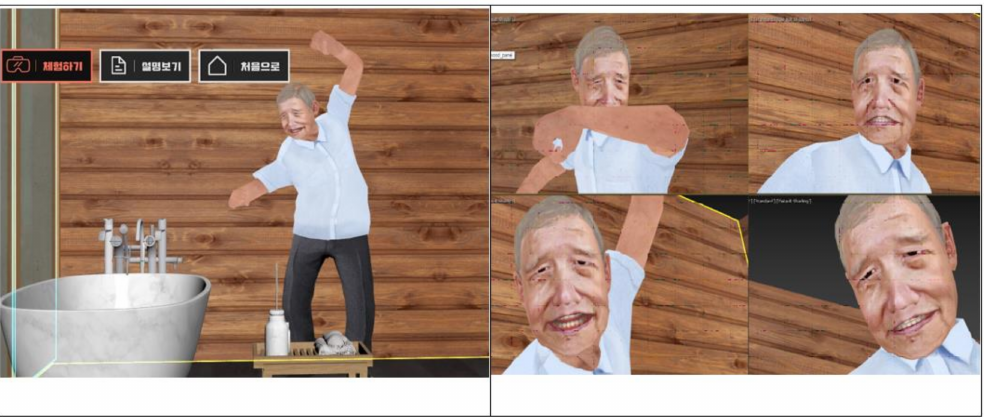
Figure 2. Scenario (Left picture icon description: Experience/Watch the video/For the first